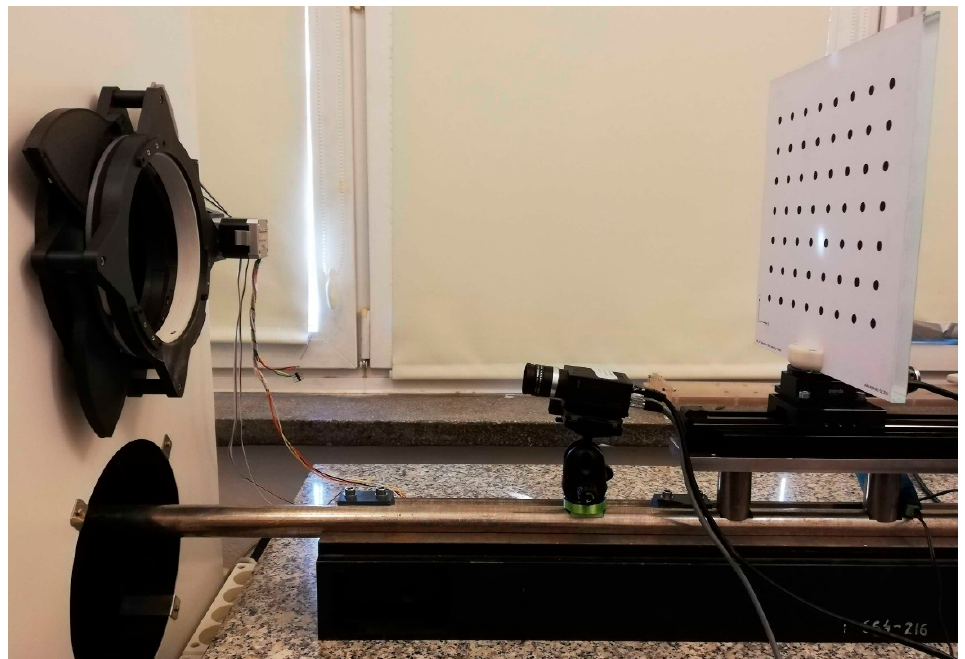
Figure 4. Photo of the test stand with the additional camera attached for the stability measurement. The light ‐ emitting diode (LED) panels were temporally removed for a better view of camera. Four circular markers with diameters of 5 mm were attached to the invar camera stage, visible to the observing camera. Figure 5 shows the sample frame with the tested camera and the markers taken by the observing camera.